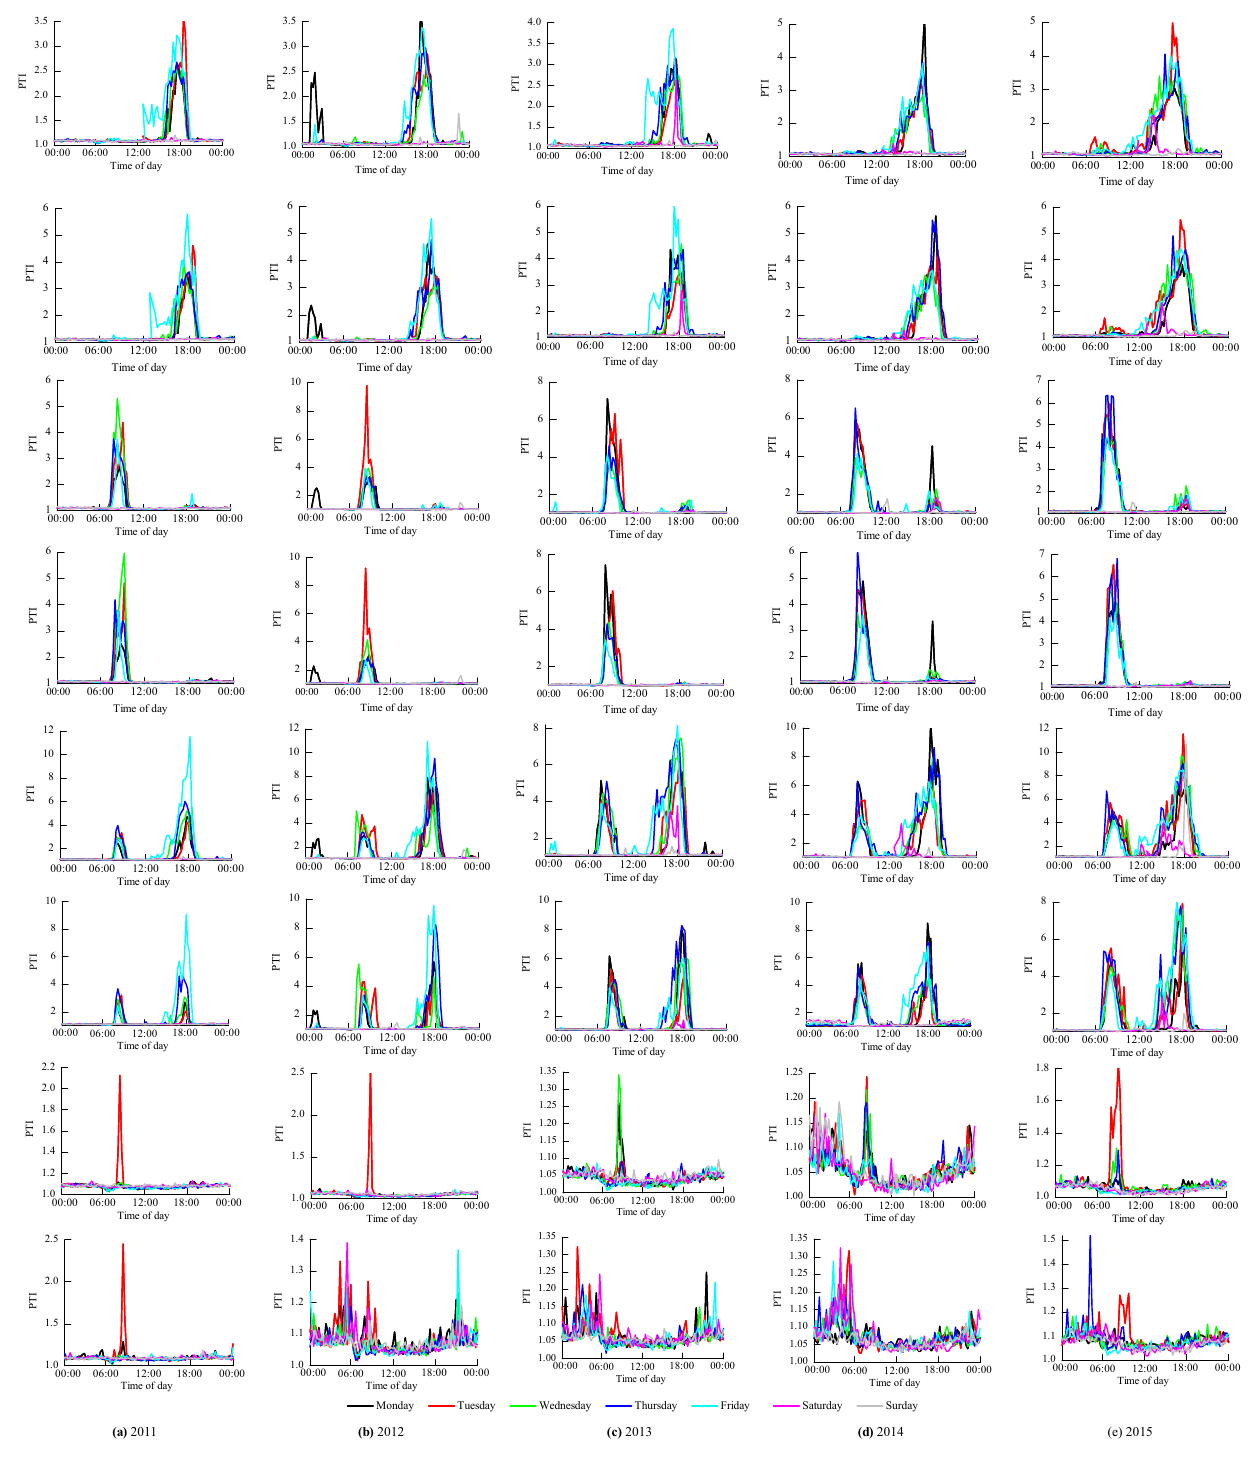
Fig. 5 TTR variability pattern of each segment for different days of week in 5